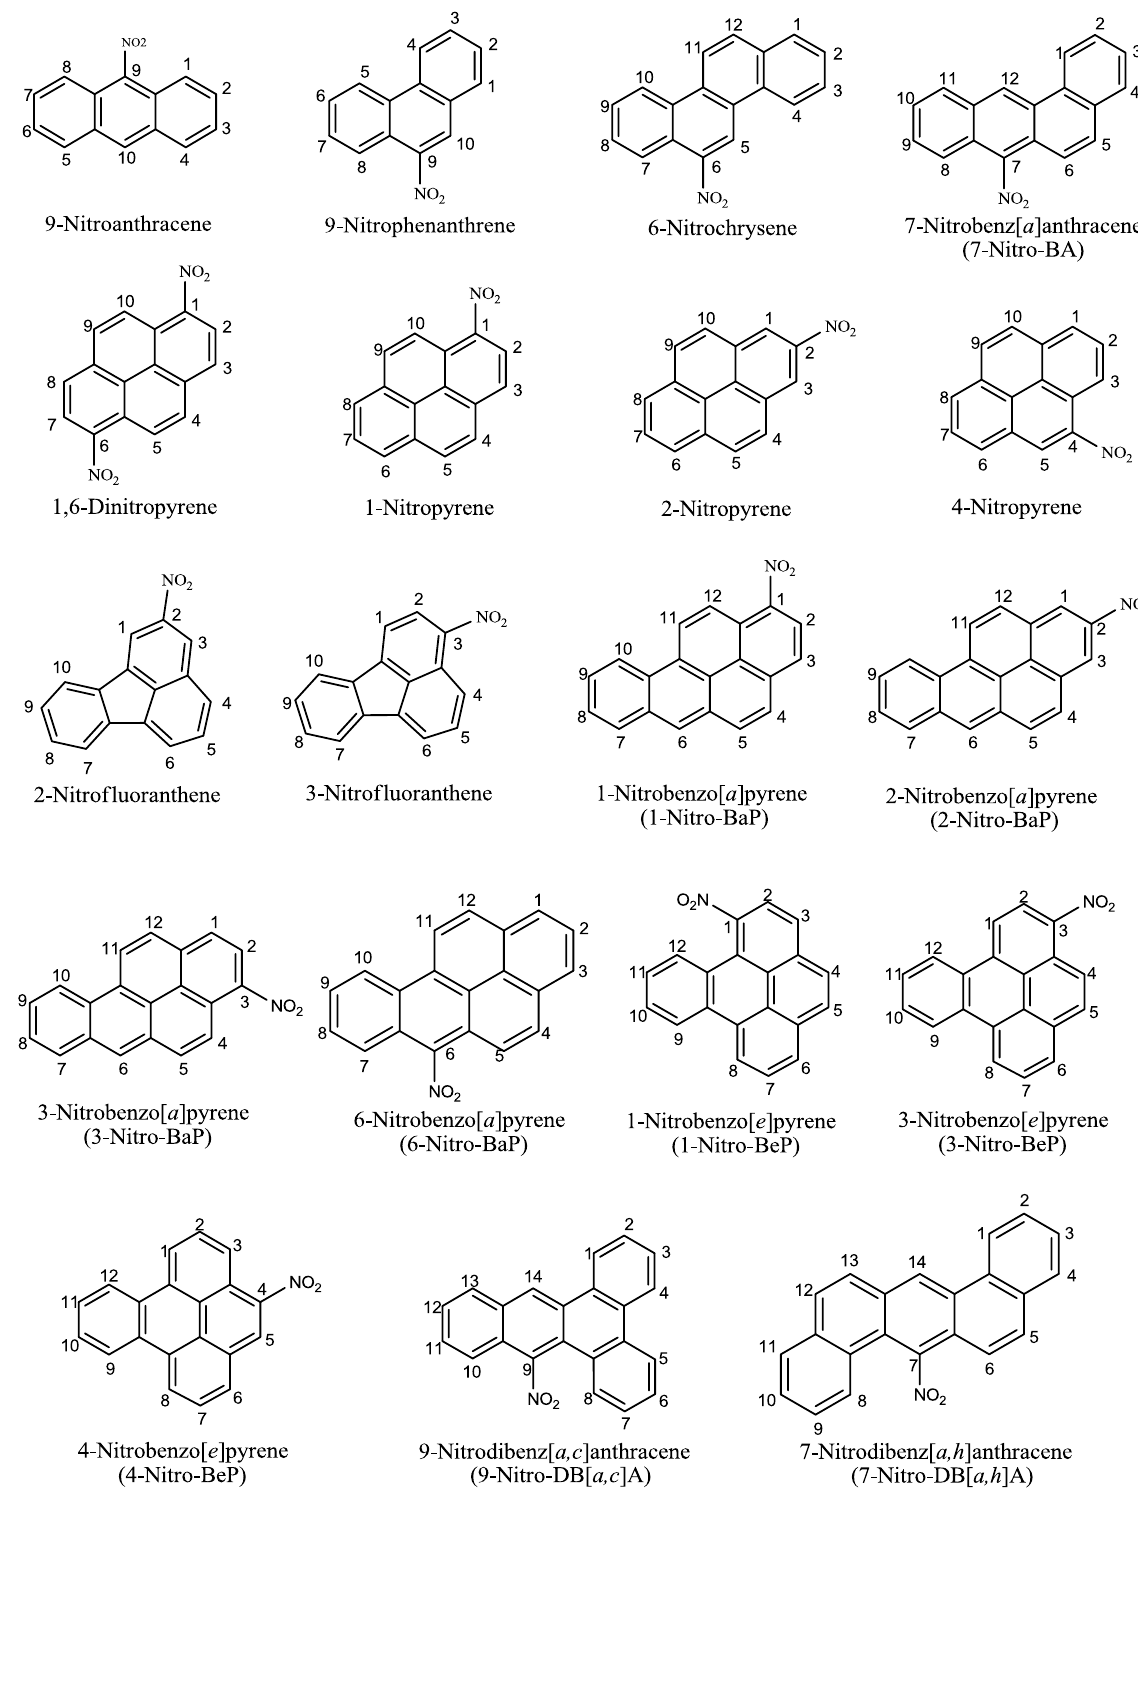
Figure 1. Structures, names, numberings, and abbreviations of nitro-PAHs used in this